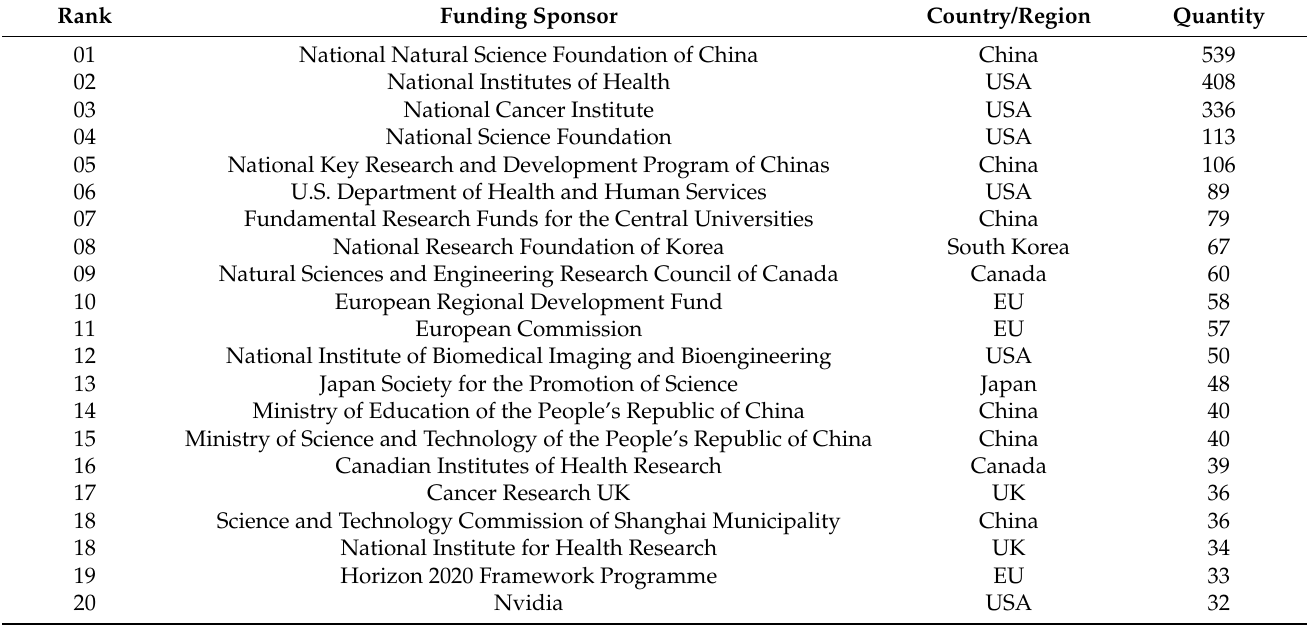
Table 5. Overview of the funding sponsors with the most funded publications.